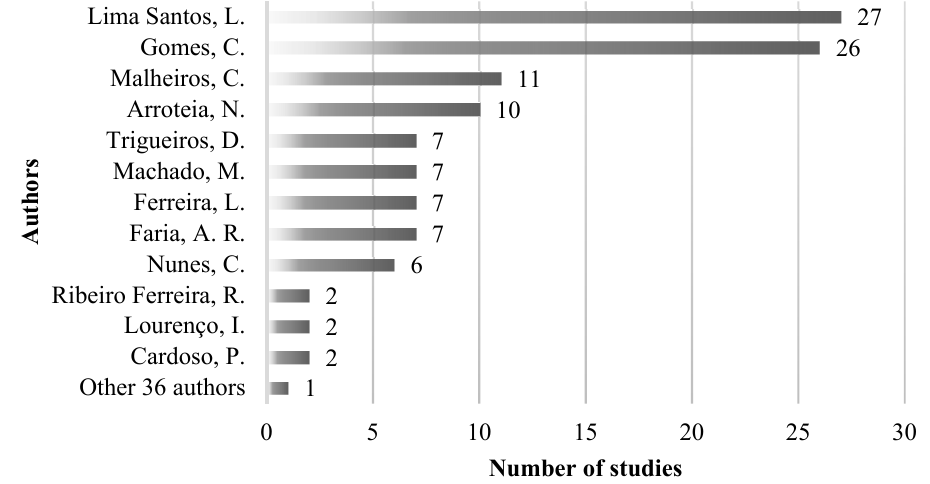
Figure 8. Authors’ ranking.